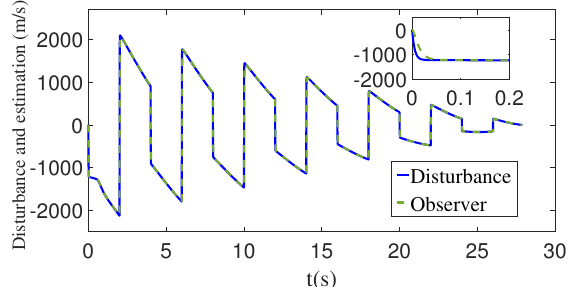
Figure 14. The disturbance d and its estimation ˆ d with square wave maneuver.